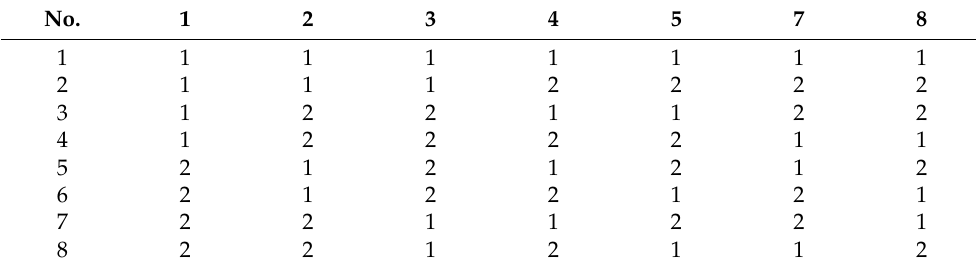
Table 8. Example of L 8 (2 7 ) orthogonal table.